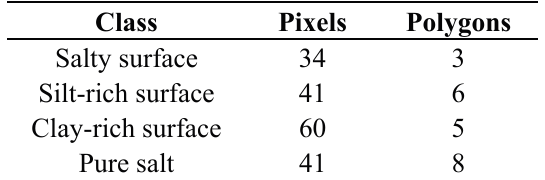
Table 2. Region of interest (ROI) statistics of each